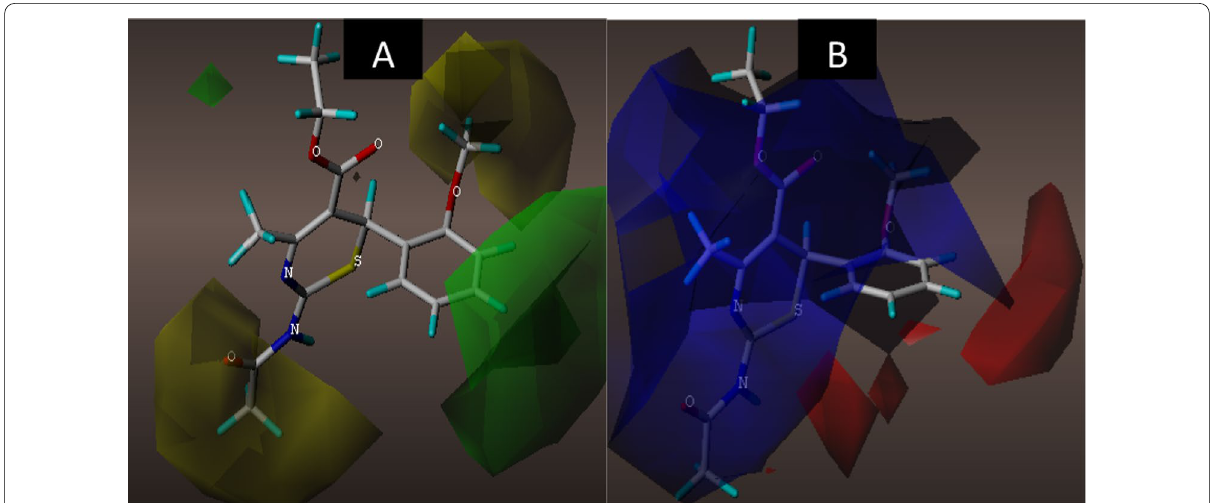
Fig. 7 3D fields of the CoMFA model for the most active compound 4. A Green areas depict desirable steric bulk, while yellow areas disfavor steric bulk, B electrostatic contour map where blue regions favor positive charge and red regions favor negative